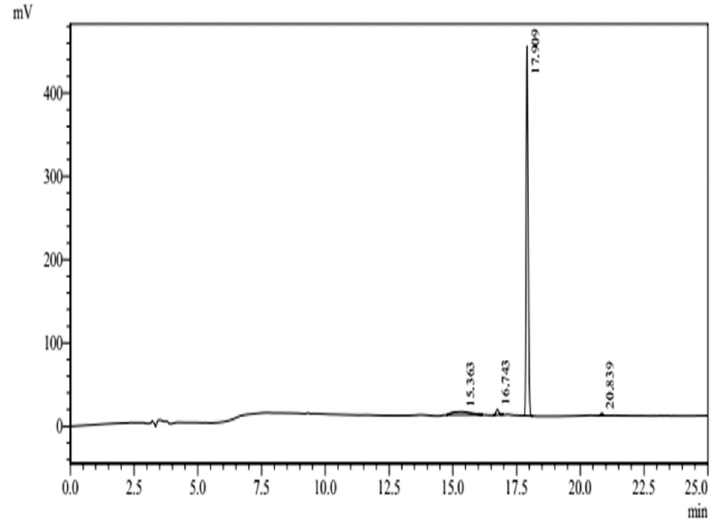
Figure A3. MS image of LA ‐ RWR ‐ PEA.